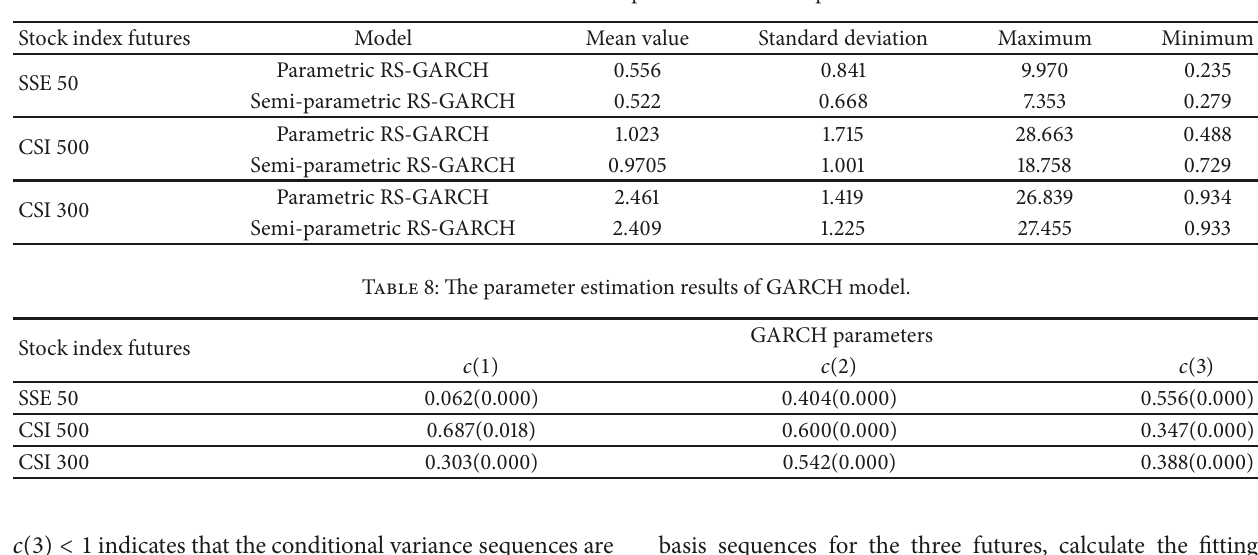
Table 7: The estimation of conditional variance for parametric and semiparametric RS-GARCH models.